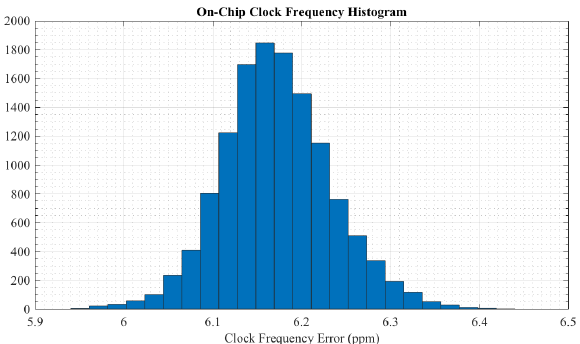
Figure 14: On-Chip clock